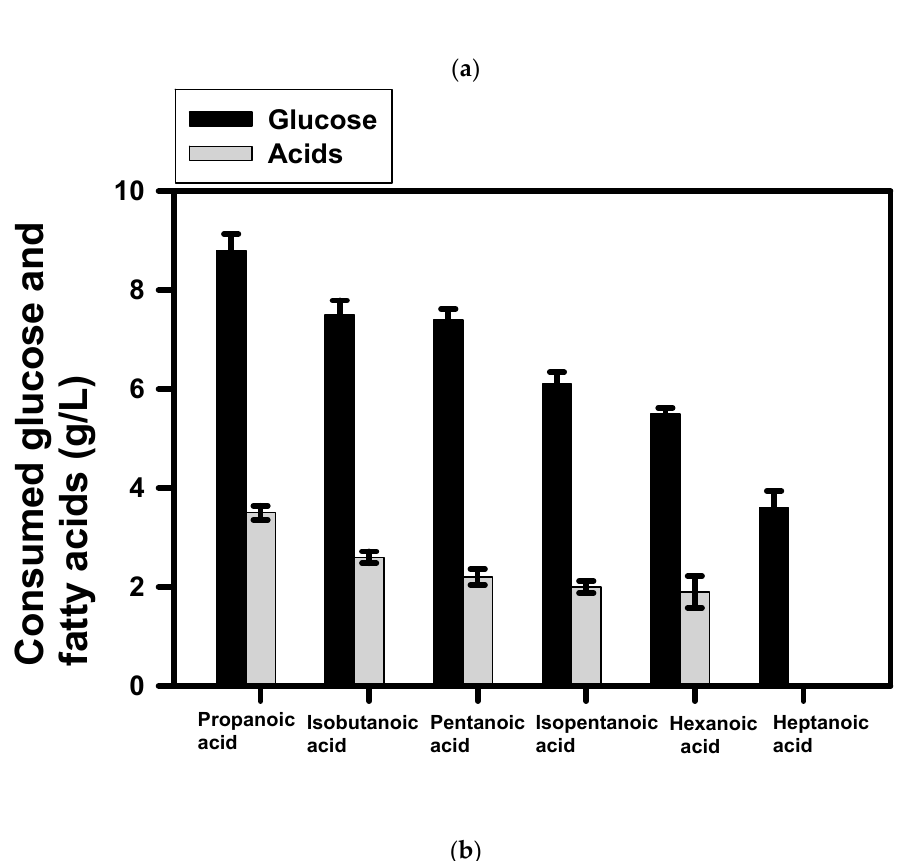
Figure 2. Production of short-chain alcohols in engineered E. coli . The fermentation was conducted with BuT-3E strain in the presence of glucose (10 g/L) and short-chain fatty acids (4 g/L) as indicated for 24 h. The experiments were conducted in triplicate. The fermentation products and the cell density (OD 550 ) were determined at the end of the fermentation ( a ). The consumption of glucose and fatty acids were measured for further analyses ( b ).